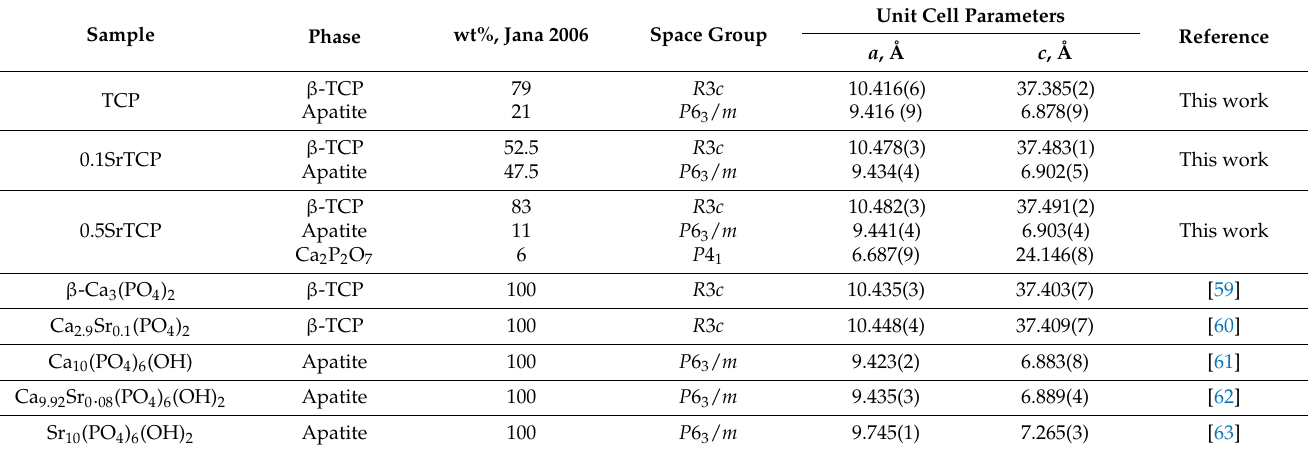
Table 1. Quantitative phase analysis of TCP and SrTCP powders and the corresponding reference